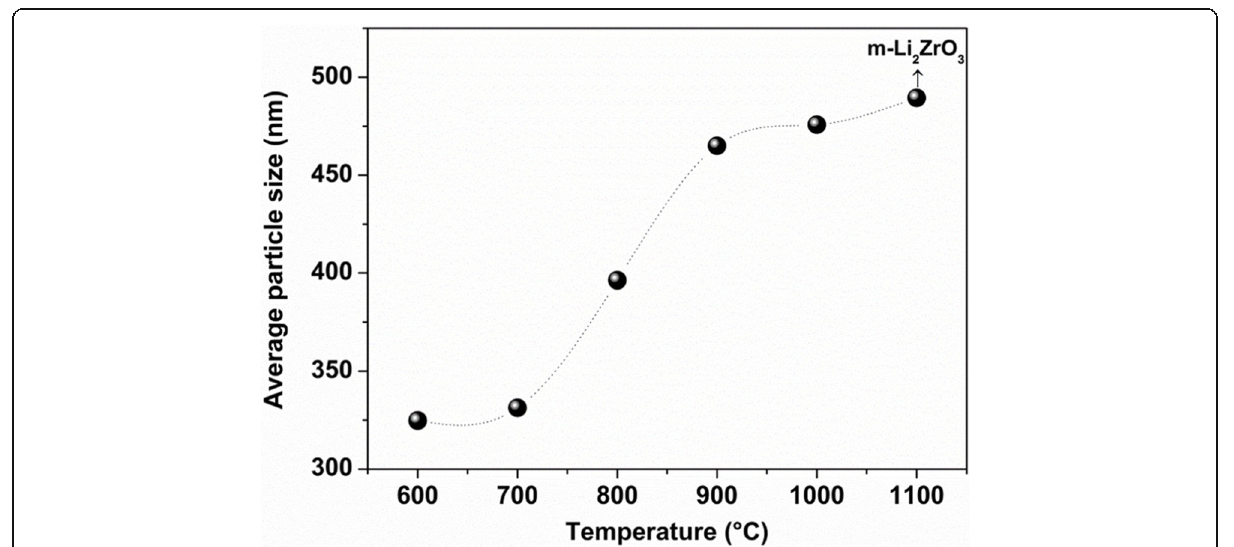
Fig. 9 Average particle size of samples prepared at different temperatures